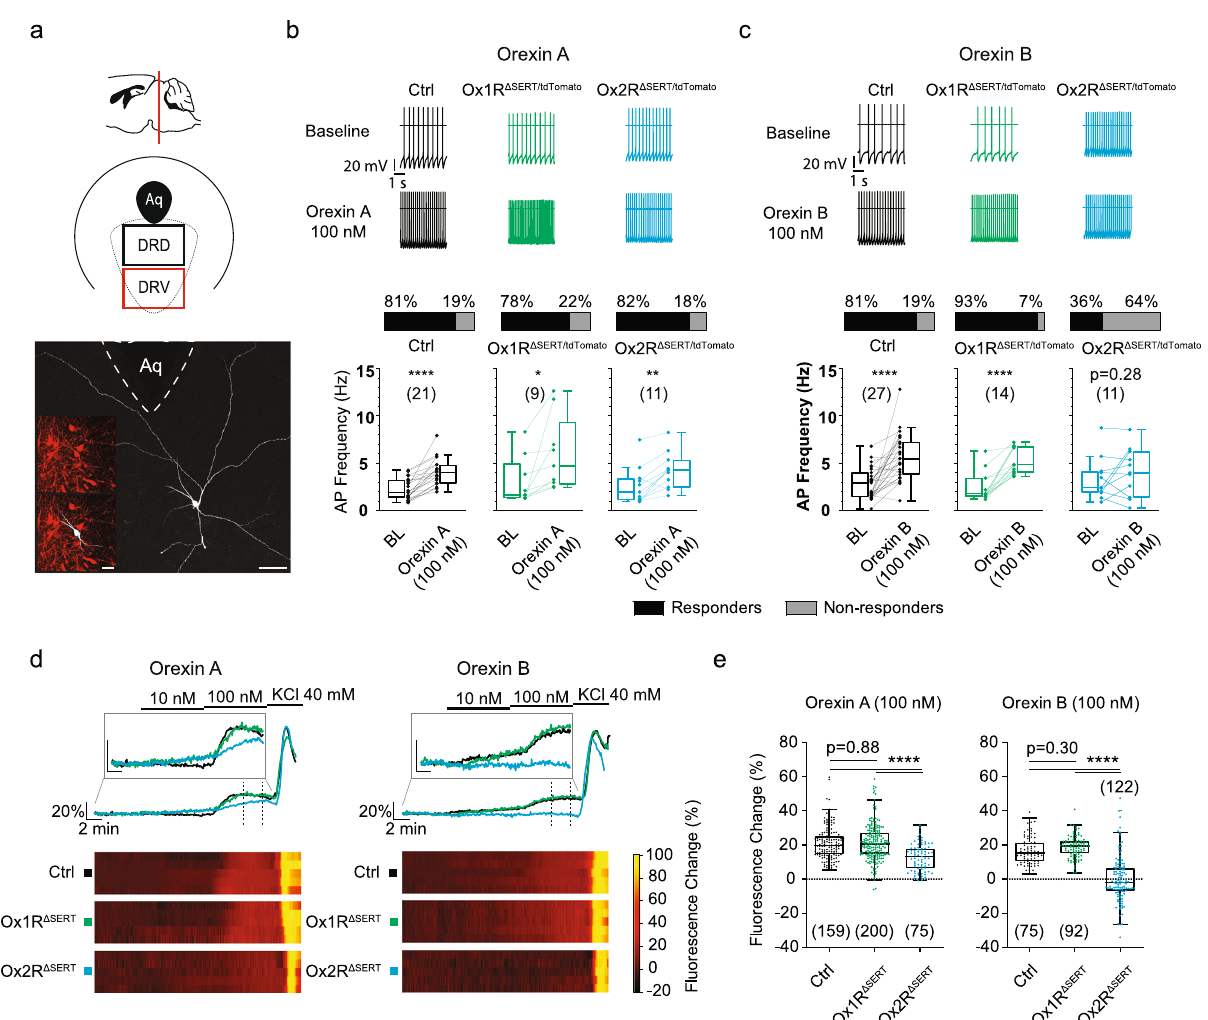
Fig. 3 Effect of orexin A and orexin B on serotonergic neurons in the dorsal raphe nucleus (DR) analyzed by patch-clamp recordings and Ca 2 + imaging with GCaMP6. Recordings were performed in brain slices from control, Ox1R Δ SERT , and Ox2R Δ SERT male mice, with tdTomato or GCaMP6 expression in serotonergic neurons for patch clamp or Ca 2 + imaging, respectively. a Schematic illustration of the dorsal raphe nucleus (dorsal (DRD), ventral (DRV)) and an exemplary image of a recorded serotonergic neuron in DRD, which was biocytin-streptavidin labeled during the experiment. Scale bar: 50 µ m. Insert: tdTomato labeling (top) and double labeling with tdTomato and biocytin-streptavidin (bottom). Scale bar: 20 µ m. b , c Orexin A ( b ) and orexin B ( c ) effect on action potential fi ring rate of serotonergic neurons in DRD. Original recordings (top) and comparisons of mean fi ring rates (bottom). The stacked bars show the percentage of individual neurons in which the increase in action potential frequency was larger than 3 × SD of the control, thus de fi ning them as responsive (see “ Methods ” ). Mean fi ring rates were compared using paired two-tailed students t -test. b Orexin A application: Ctrl, p < 0.0001, n = 21; Ox1R Δ SERT : p = 0.03, n = 9; Ox2R Δ SERT : p = 0.0018, n = 11. c Orexin B application: Ctrl, p < 0.0001, n = 27; Ox1R Δ SERT : p < 0.0001, n = 14; Ox2R Δ SERT : p = 0.28, n = 11. Abbreviation: baseline (BL). d , e Orexin A and orexin B effect on [Ca 2 + ] i of serotonergic neurons in DRV measured with GCaMP6. d Original recordings (top) and heat maps of fi ve individual neurons for each set of experiments (bottom). The recordings show the responses to the orexins and high K + saline. Dashed lines indicate the range where the responses were quanti fi ed. e Calcium responses upon 100 nM orexin A and orexin B. Data are shown as the percentage of the maximal response to high K + saline. Mean increases in [Ca 2 + ] i between experimental groups were compared, performing ANOVA with post hoc Tukey tests. Orexin A application: Ctrl vs Ox1R Δ SERT , p = 0.88; Ctrl vs Ox2R Δ SERT , p < 0.0001; Ox1R Δ SERT vs Ox2R Δ SERT